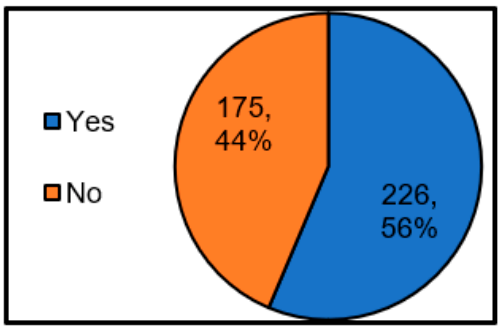
Figure 8. Presence or absence of involvement of local government officials who are the shelter operating entities.